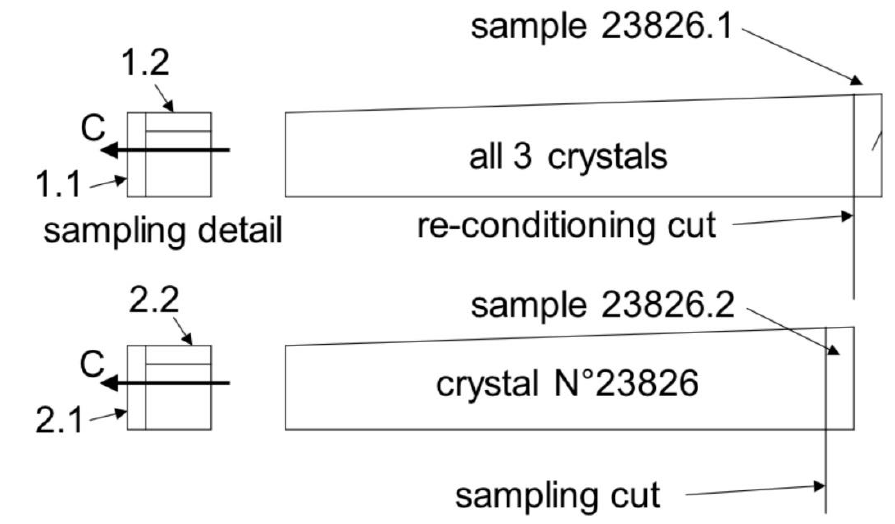
Figure 3. The schematics of the sampling map.